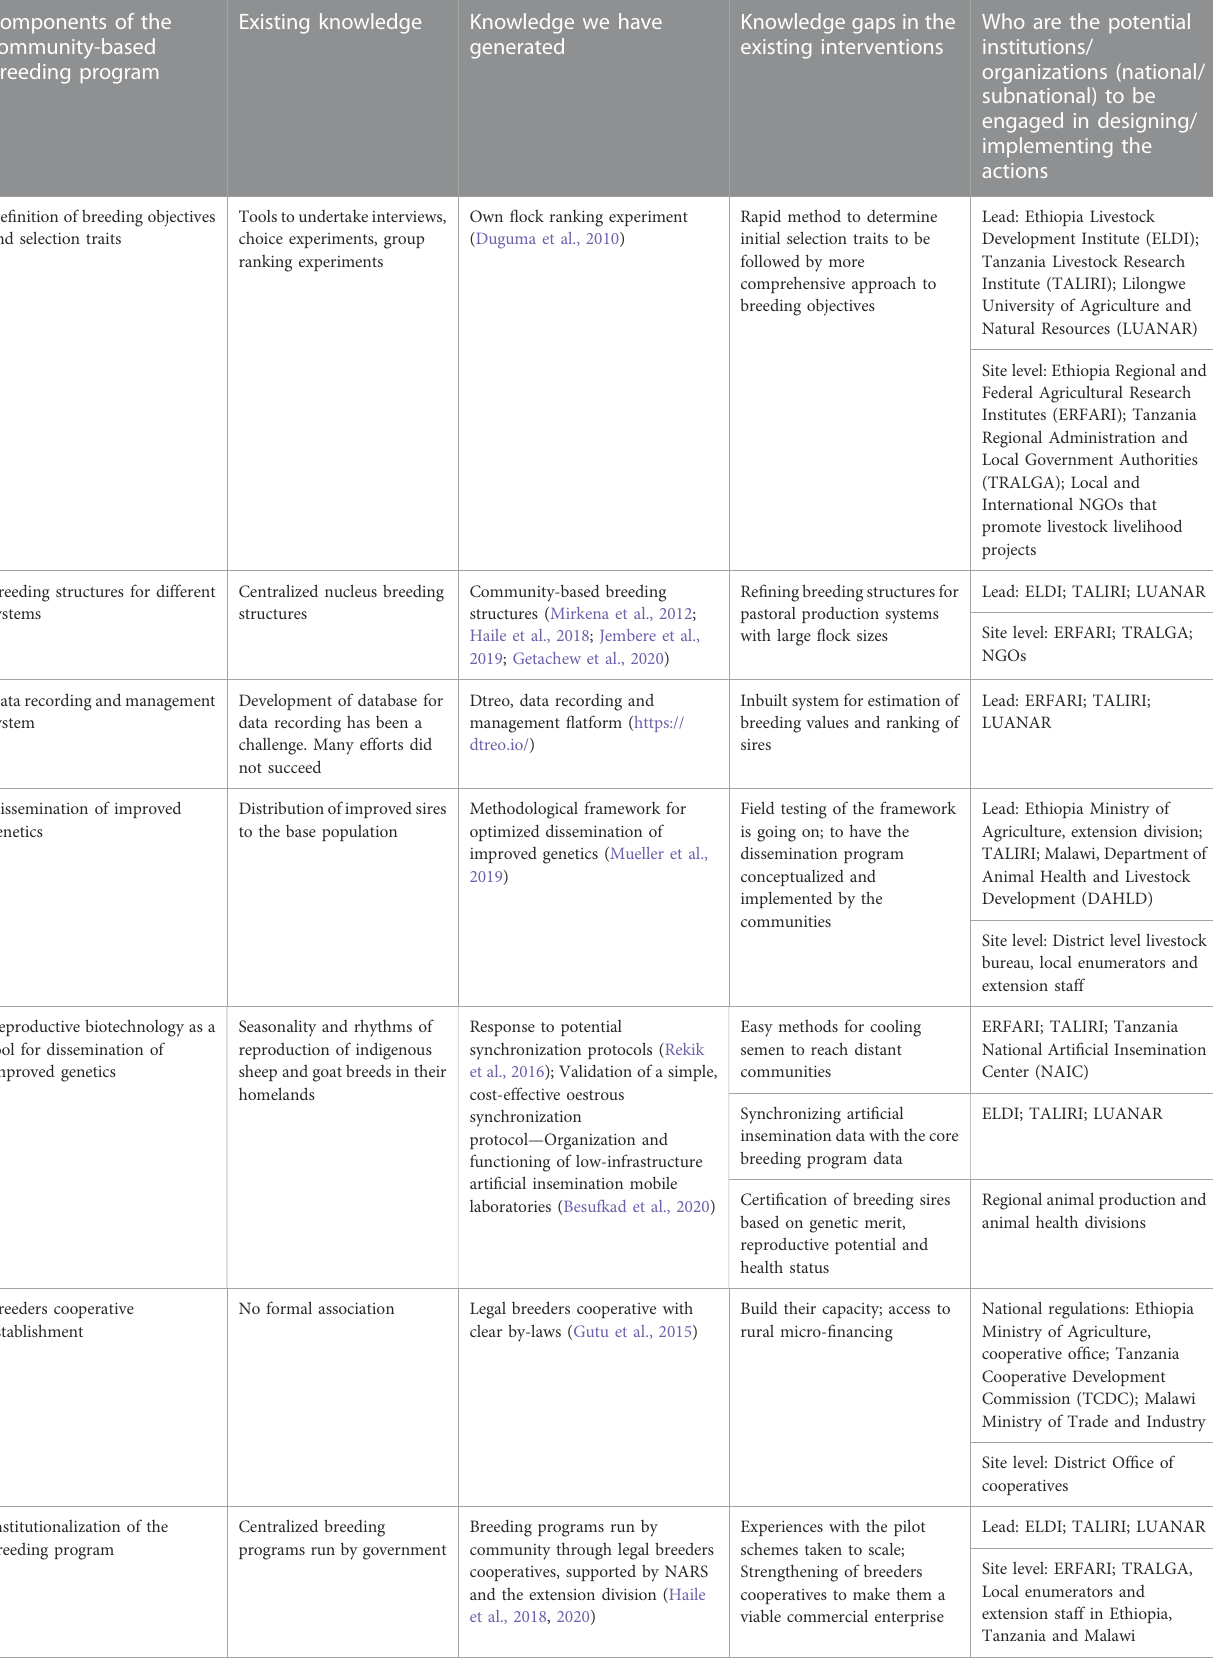
TABLE 1 Major requirements for setting up community-based breeding programs and support services needed. Components of the